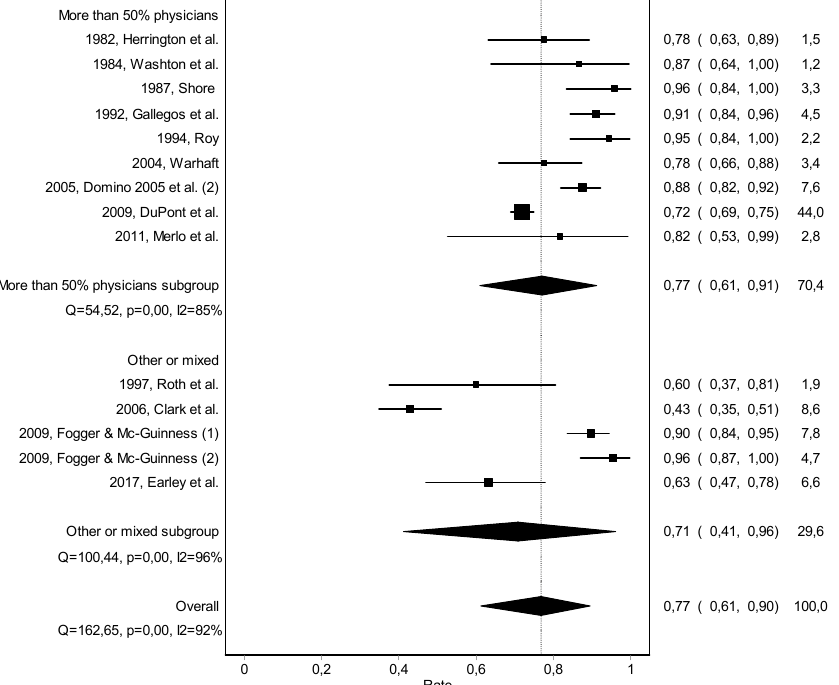
Figure A10. Forest plot of the pooled work retention rate—subgroup analysis based on type of healthcare professional.